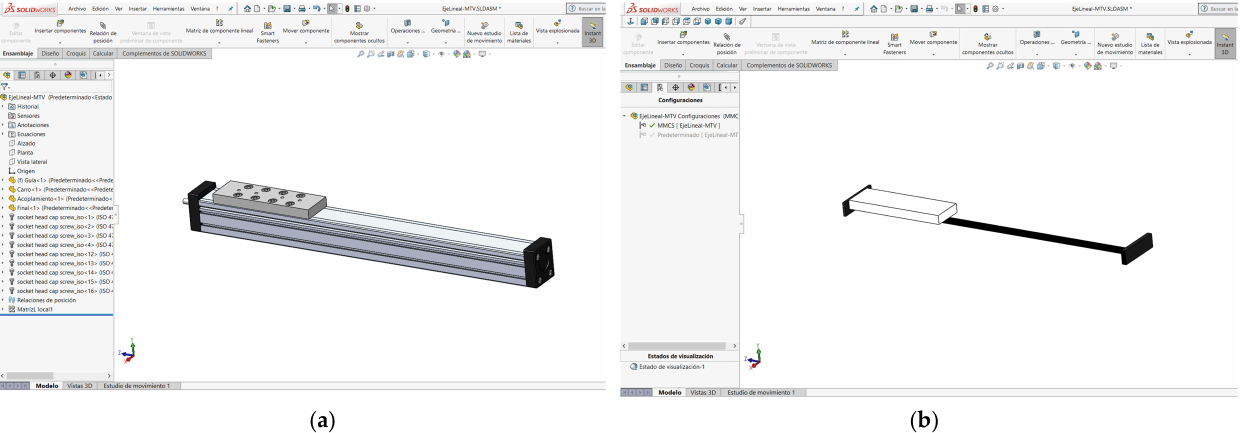
Figure 21. Linear servo axis computer-aided design (CAD) layers. ( a ) 3D CAD layer; ( b ) MMCS CAD layer.